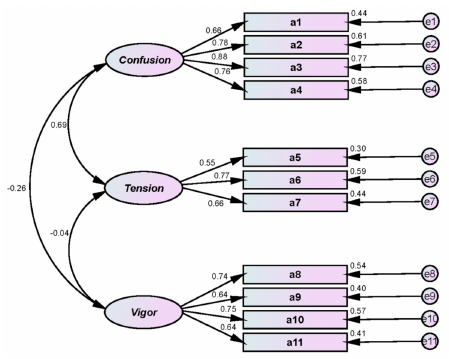
Figure 1. Mood states